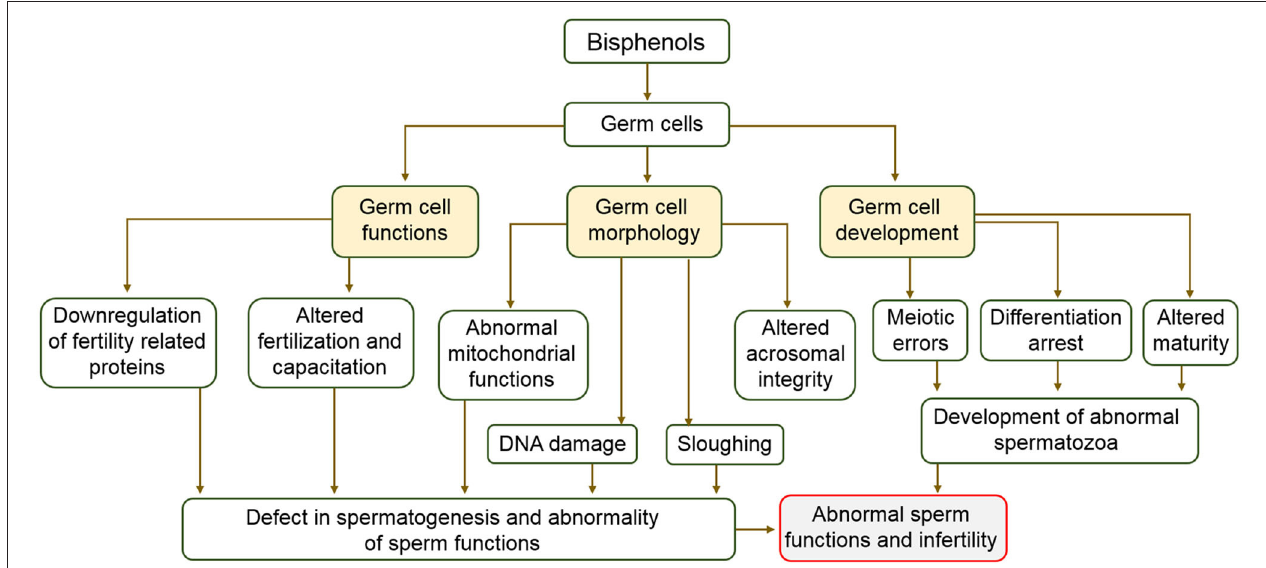
FIGURE 4 | Schematic description of the effects of bisphenols on germ cell and male